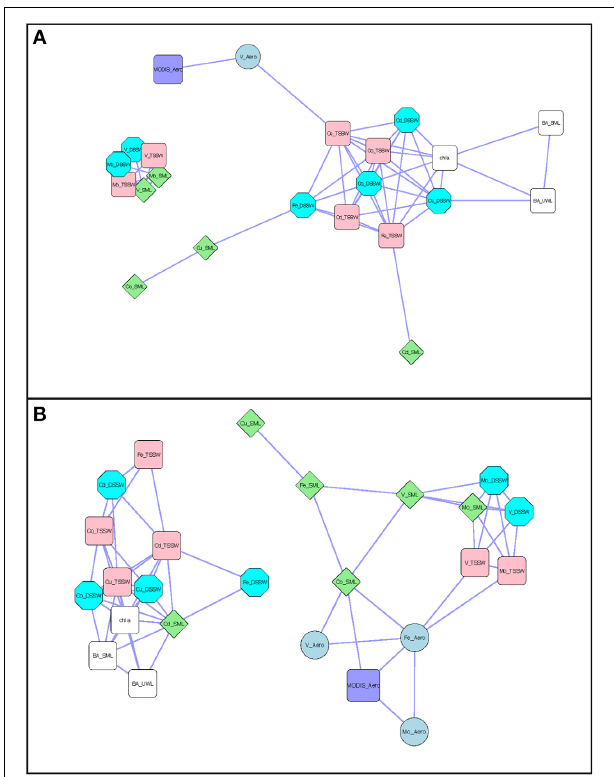
FIGURE 5 | Network analysis results obtained for transect 1 (A) and transect 2 (B). Elements in the surface microlayer (SML): Cd_SML, Co_SML, Cu_SML, Fe_SML, Mo_SML and V_SML; elements in the unfiltered fraction of the subsurface water (TSSW): Cd_TSSW, Co_TSSW, Cu_TSSW, Fe_TSSW, Mo_TSSW and V_TSSW; Elements in the dissolved fraction of the subsurface water (DSSW); Cd_DSSW, Co_DSSW, Cu_DSSW, Fe_DSSW, Mo_DSSW and V_DSSW; Elements in aerosols particles (Aero): Fe_Aero, Mo_Aero and V_Aero; Density of particles in the atmosphere from satellite observations (MODIS_Aero); chlorophyll-a concentrations (chla); and bacterial abundance in the SML (BA_SML) and in the underlying water column (BA_UWL). Nodes (SML: green diamonds; TSSW, red squares; DSSW, cyan octagons; Aero: blue circles; MODIS_Aero, purple square; chla and Ba_SML and Ba_UWL: white squares) correspond to the measured concentrations or abundances of the variables and edges represent a significant ( p < 0 . 05) positive correlation between the two variables